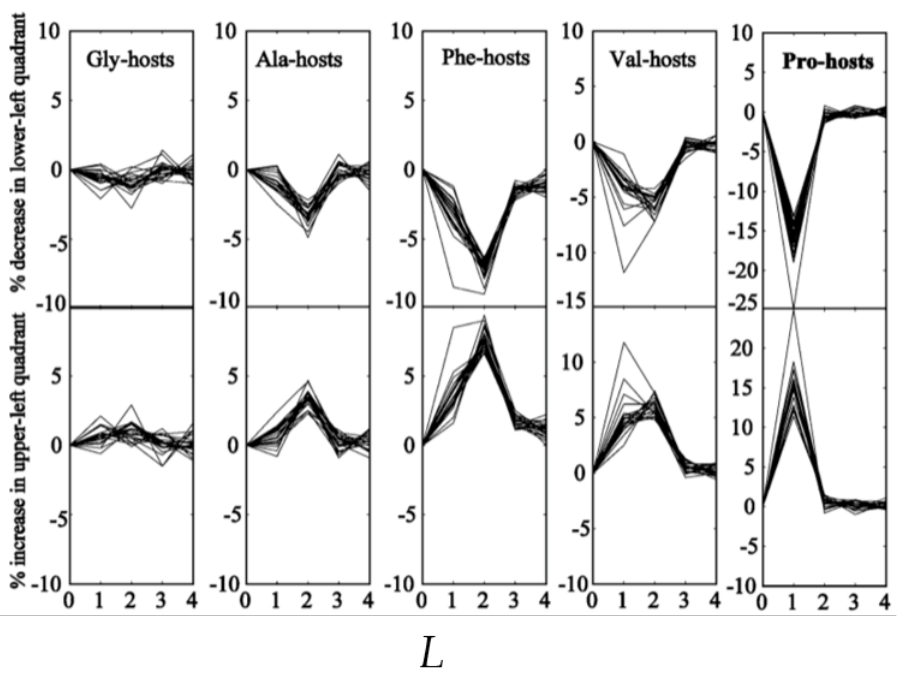
Figure 8. Changes in the propensity of 22 different guest residues (20 natural amino acid residues, norvaline and norleucine, each of which represented by a curve) for conformations in the lower and upper left quadrant of the Ramachandran plot as a function of the increasing length L of the oligopeptide. The host guest system is defined in the text. Taken from [74] with permission, 2005, American Chemical Society